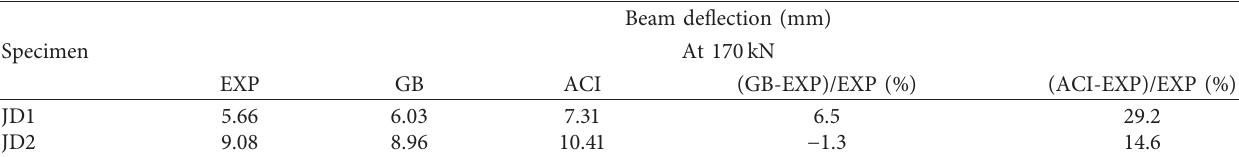
Table 4: Comparison of experimental and code predicted beam deflection at